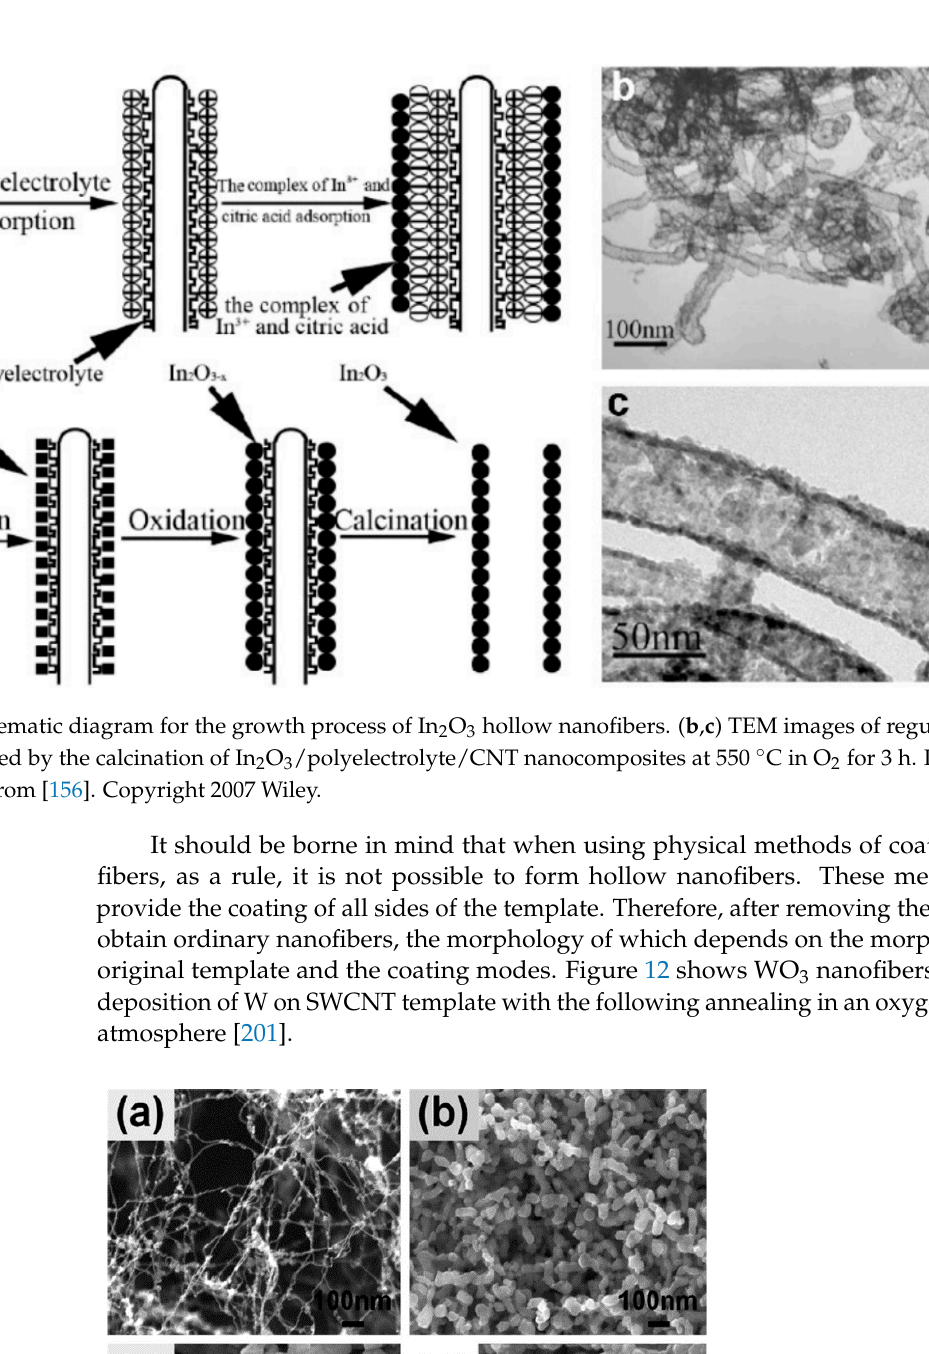
Figure 12. ( a ) The morphology of the SWCNT template. ( b – d ) WO 3 nanowire morphology for W